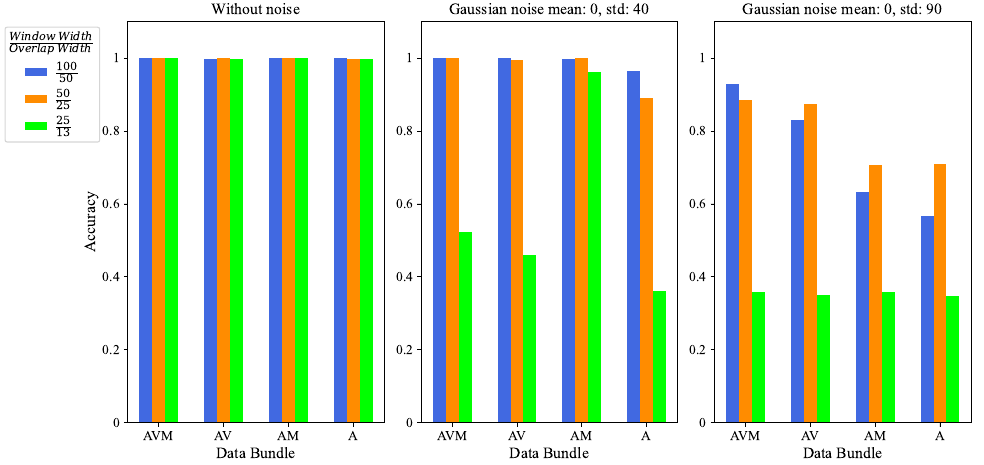
Figure 14. The effect of window width and data bundle variations on accuracy of LeNet5 recognition model in the absence and presence of noise corruptions on the green hen